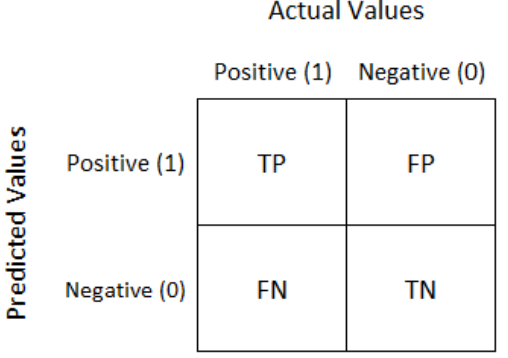
Figure 3. The confusion matrix compares the predicted values with respect to the actual real values. In particular, the matrix elements are defined as: TP, true positive, the cases in which we predicted that there is blood and there is actually blood; TN, true negative, where we predicted there is no blood and there is no blood; FP, false positive, we predicted there is blood and instead there is no blood; and, FN, false negative, where we predicted there is no blood but there actually is